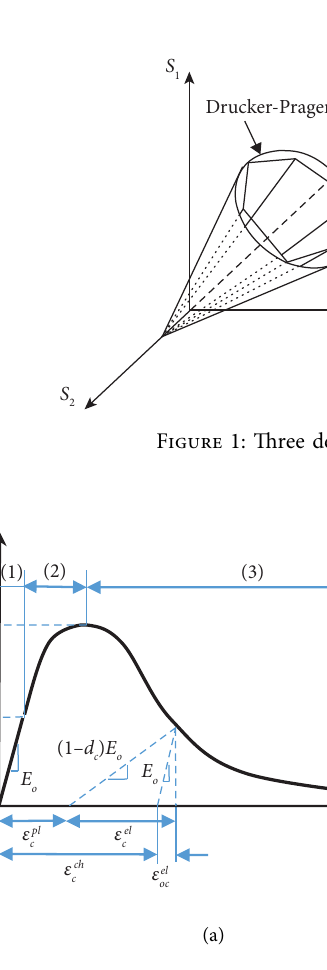
Figure 2: Concrete behavior for uniaxial model. (a) Compression behavior of concrete. (b) Tension behavior of